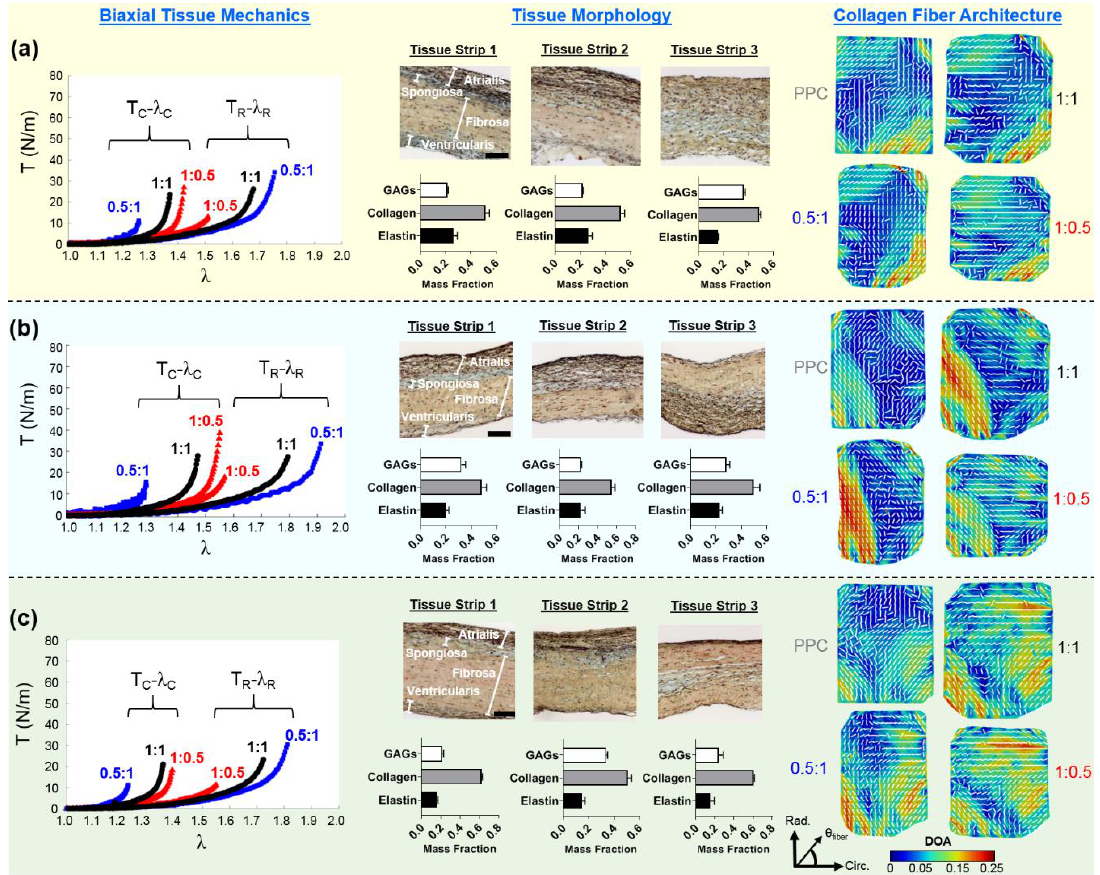
Figure 3. Representative heart #1 quantifications, as follows: ( left ) membrane tension (T) versus tissue stretch (λ) results of biaxial testing experiments (subscripts C and R stand for the circumferential and radial directions, respectively), ( middle ) histology-based evaluations of tissue’s morphology and constituents, and ( right ) the pSFDI-quantified collagen fiber architecture for: ( a ) the TVAL, ( b ) the TVPL, and ( c ) the TVSL specimens. In the right column, the dash lines represent the predicted fiber orientation angle and the colormaps denote the DOA.